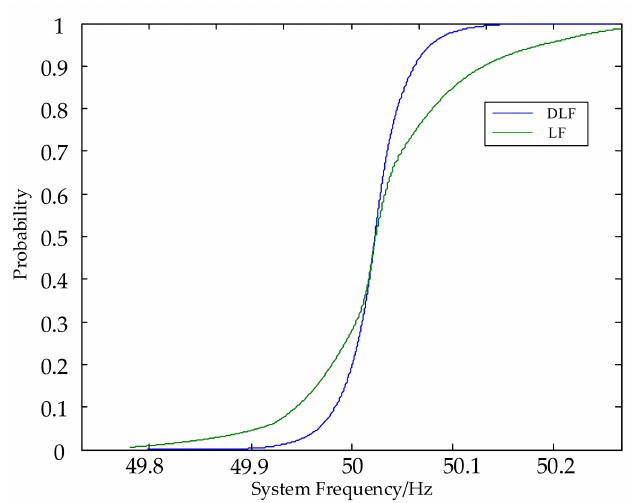
Figure 5. Frequency distribution based on DLF and LF.